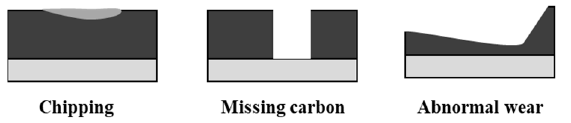
Figure 2. Different deformation conditions that occur on the contact strip of the pantograph (front view) .